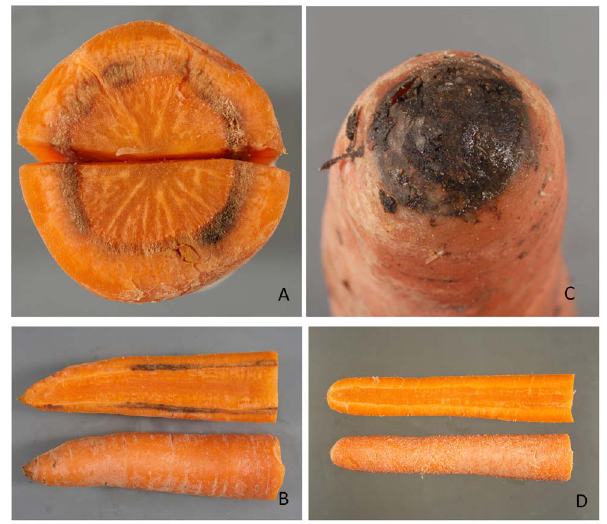
Figure 1. Examples of symptoms of ‘affected’ carrot samples (a) Cross section of carrot root showing internal necrosis around the root core. (b) Internal necrosis of carrot root along the root core. (c) External necrosis of the root tip. (d) Unaffected carrot.